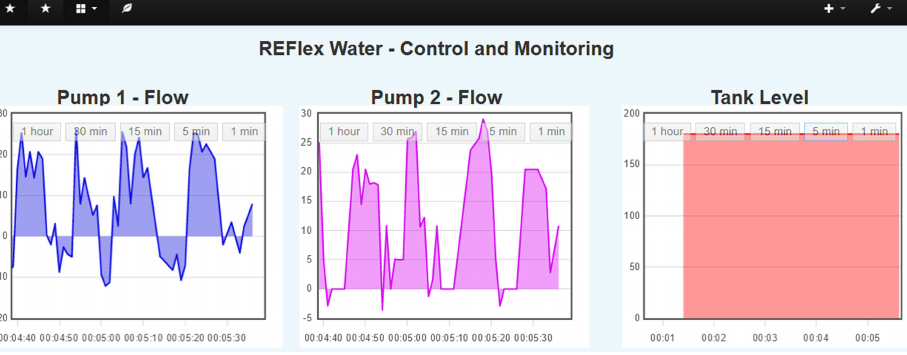
Figure 13. Monitoring